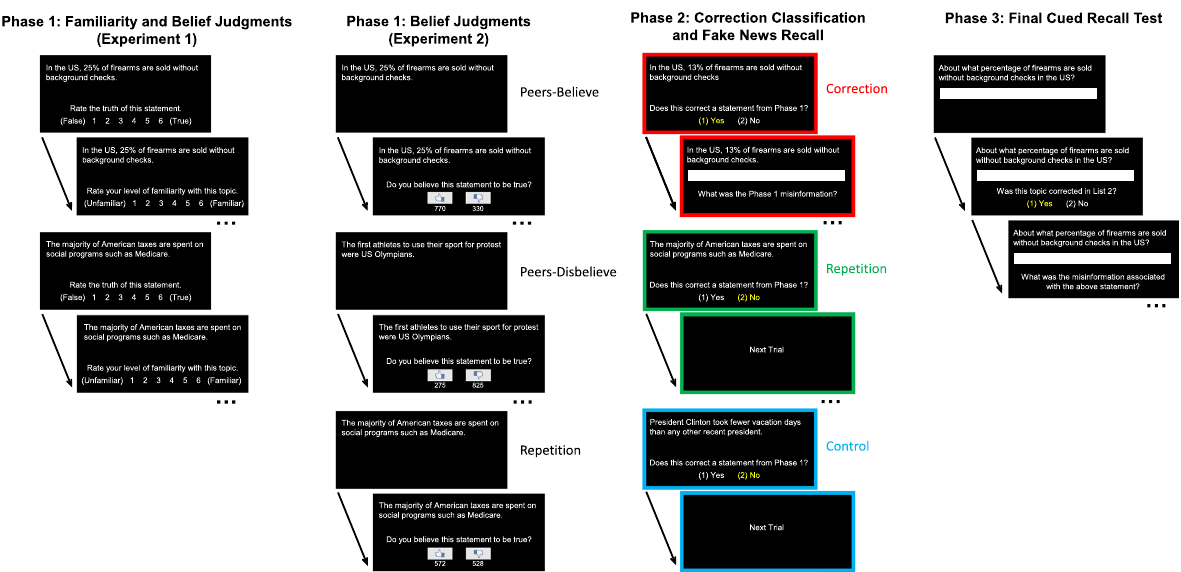
Fig. 1 Schematic of the Procedure: Experiments 1 and 2. A schematic overview of the trial structures from the procedures in both experiments. The main difference between experiments was the trial structure in Phase 1: In Experiment 1, participants rated the familiarity and believability of headlines; In Experiment 2, participants rated the believability of each headline, which displayed the number of fictional peers who believed and disbelieved the headline. The majority of peers believed the headline in the Peers-Believe condition, and the minority of peers believed the headline in the Peers-Disbelieve condition. Phase 2 included Correction headlines that corrected fake news from Phase 1 (red borders), Repetition headlines that repeated real news from Phase 1 (green borders), and Control headlines that only appeared Phase 2 (blue borders). Note that all the trials in the Peers-Believe and Peers-Disbelieve conditions were later corrected, whereas that Phase 1 trials in the Repetition condition always included a negligible difference in peer beliefs. In both experiments, during Phase 2, participants indicated when they detected headlines that contradicted fake news, and if so, attempted to recall fake news from Phase 1. In the first slide of Phase 2 trials, the yellow highlights for the “Yes” and “No” judgments indicate the correct classification of each headline type upon which the second slide was contingent. During Phase 3, participants first recalled Phase 2 real news details, then indicated those for which fake news was corrected in Phase 2, and for those, attempted to recall the Phase 1 fake